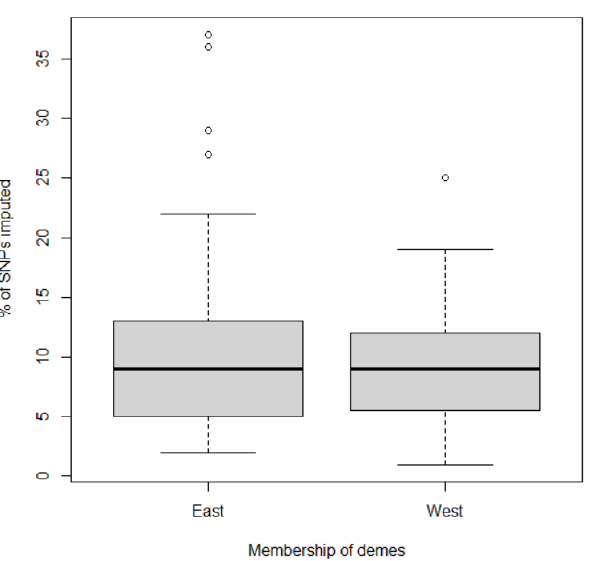
Figure A3. Box plot showing percentage of imputed SNPs for samples from two inferred demes using fastSTRUCTURE